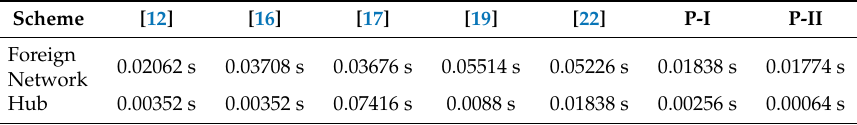
Table 7. Comparison of the scheme computation time.